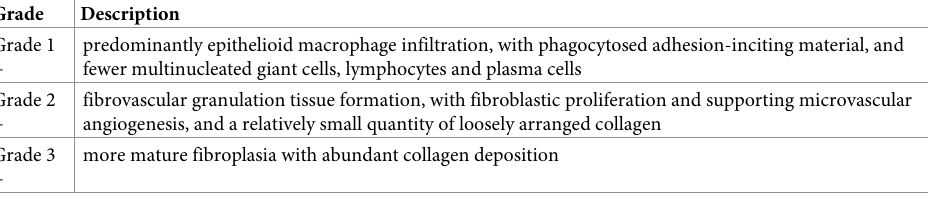
Table 2. Grade of inflammation and cellular proliferation in adhesion (H&E).